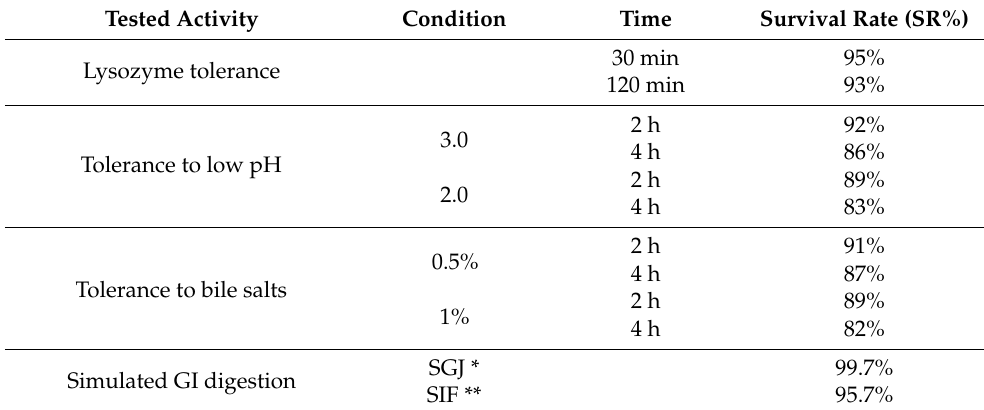
Tolerance to bile